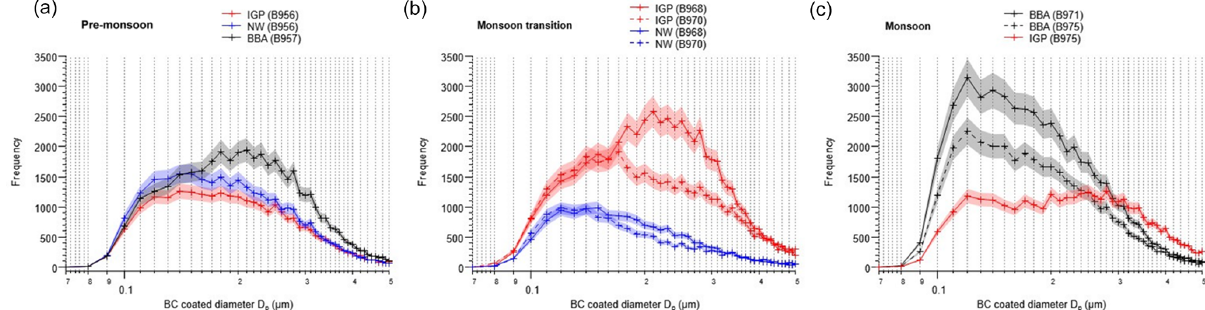
Figure 9. BC coated diameter ( D p ) histograms for (a) pre-monsoon season, (b) monsoon transition, and (c) monsoon season. The shading shows the square root (%) errors for data series. Orange represents the IGP, with blue representing NW India (JAI–JOD) and black NE India